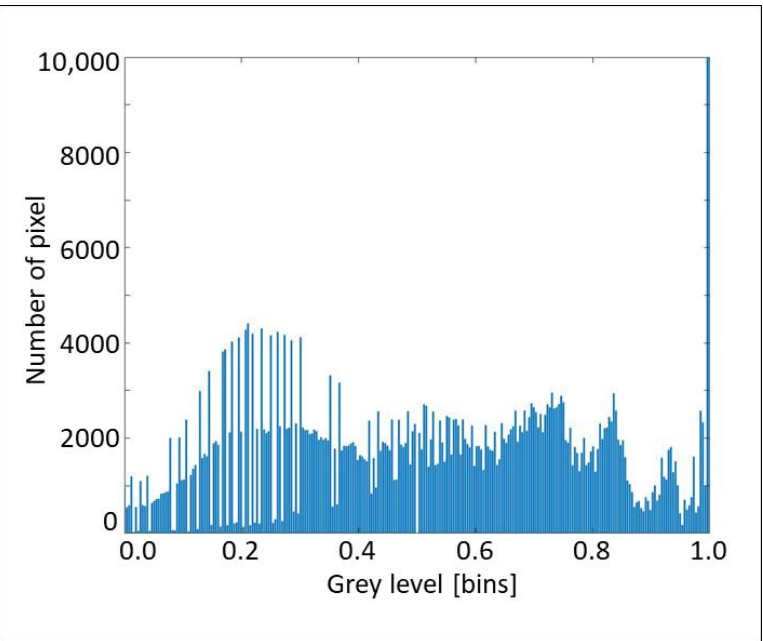
Figure 17. Histogram of grey scale vs. number of pixels for the section A concerning layers and waves.